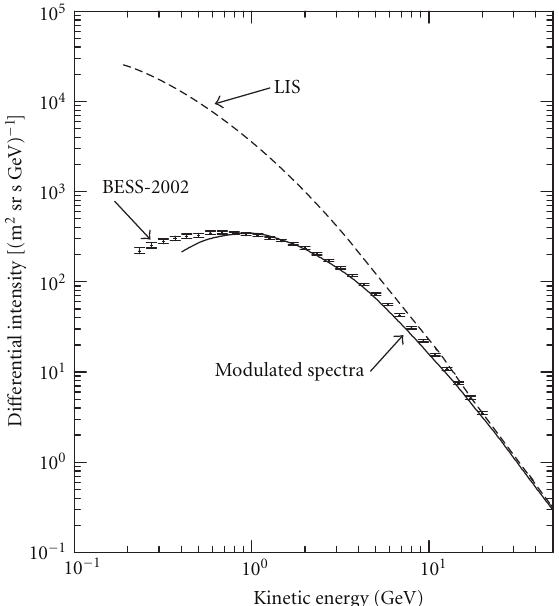
(GeV)10 − 1 Kinetic energy F 9: Proton differential intensity determined with the HelMod code (continuous line) compared to the experimental data of BESS- 2002; the dashed line is the LIS (see the text).